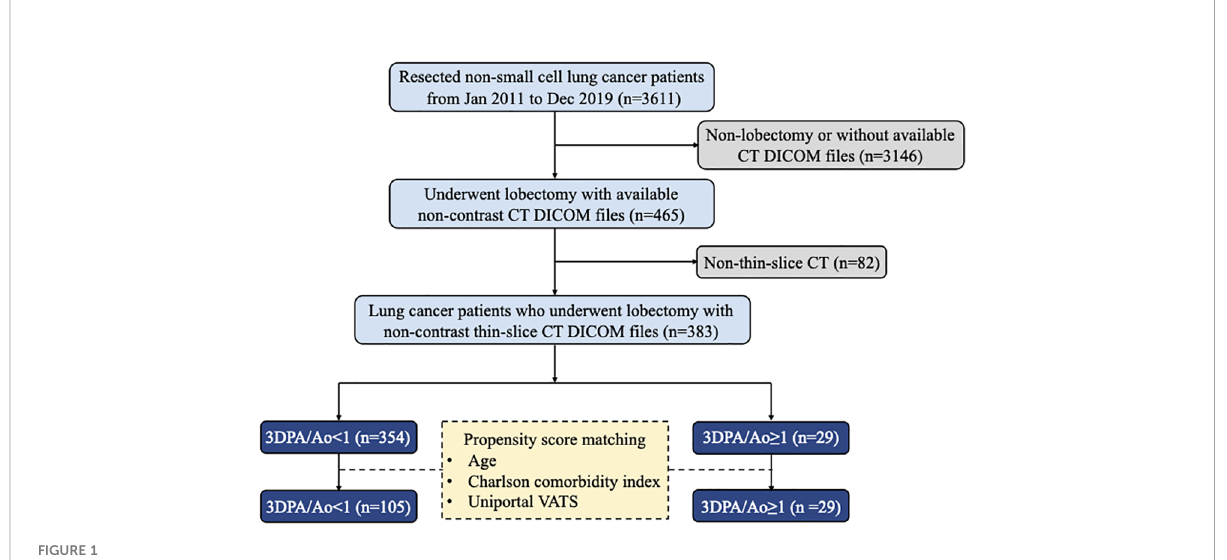
FIGURE 1 Flow diagram of patient